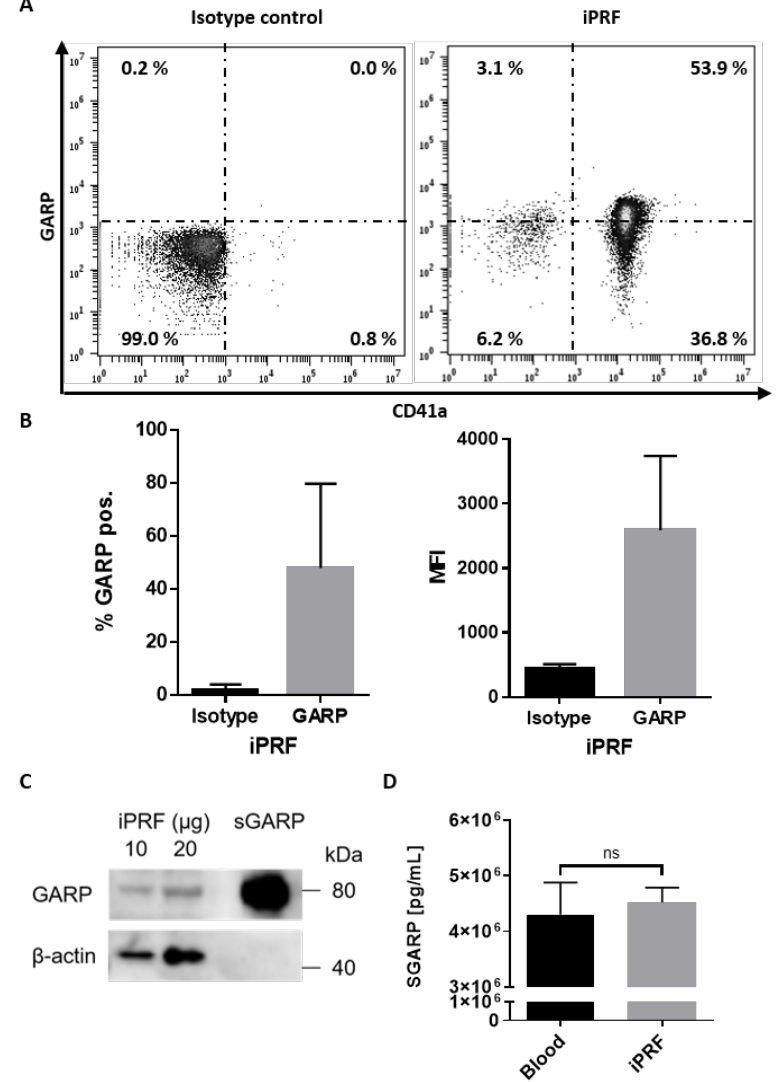
Figure 1. Glycoprotein A repetitions predominant (GARP) is expressed on the surface of platelets and exists as a soluble factor found in liquid platelet rich fibrin (iPRF). ( A , B ) iPRF was stained directly for the platelet marker, CD41a, and GARP and underwent flow cytometric analysis. Isotype antibodies were used as a control. ( A ) Dot blots show one representative result. ( B ) Bar diagrams of GARP expression show the pooled data of percentages (%) of GARP positive platelets in iPRF and the mean fluorescence intensity (MFI) of GARP (n = 3 ± SD, analyzed by paired Students T -tests). ( C ) Expression of GARP in iPRF was analyzed via Western blot. iPRF lysate was loaded in increasing amounts. Recombinant soluble GARP (sGARP) was loaded at 1 ng/lane and served as a positive control, whereas β -actin acted as the loading control. ( D ) Bar graph shows the soluble GARP (sGARP) levels in peripheral blood and iPRF analyzed via ELISA (n = 3 ± SD, ns determined by paired Students T -tests).